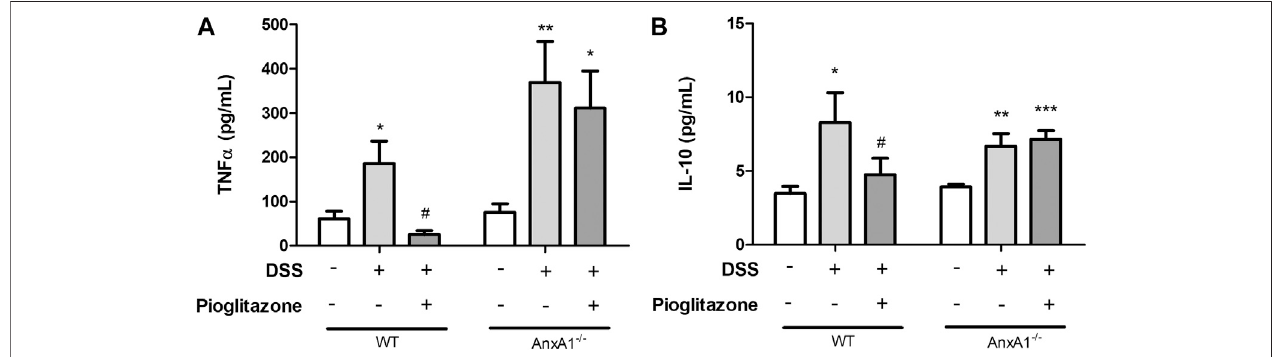
FIGURE 3 | Cytokines from tissue explants. Wild type and AnxA1 − / − mice were euthanized at the end of the experimental model; large intestines were harvested andafragmentofthecolonwascultured;after24 h,supernatantswerecollectedandsecretionofTNF α (A) andIL-10 (B) wasassessedviaELISA.*,**,*** p < 0.05,0.01, 0.001 in comparison to the control group; # p < 0.05 in comparison to the DSS-treated group. Data were statistically analyzed using One-Way ANOVA followed by Tukey ’ s post-test ( n (cid:2) 6). Results are expressed as mean ±